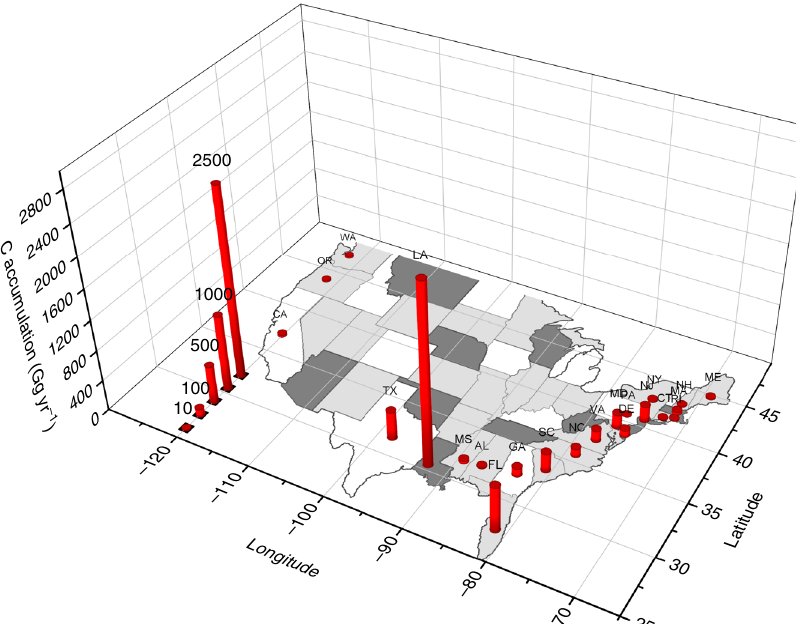
Fig. 5 State level coastal wetland C accumulation (Gg yr − 1 ) in the tidal wetlands of the conterminous United